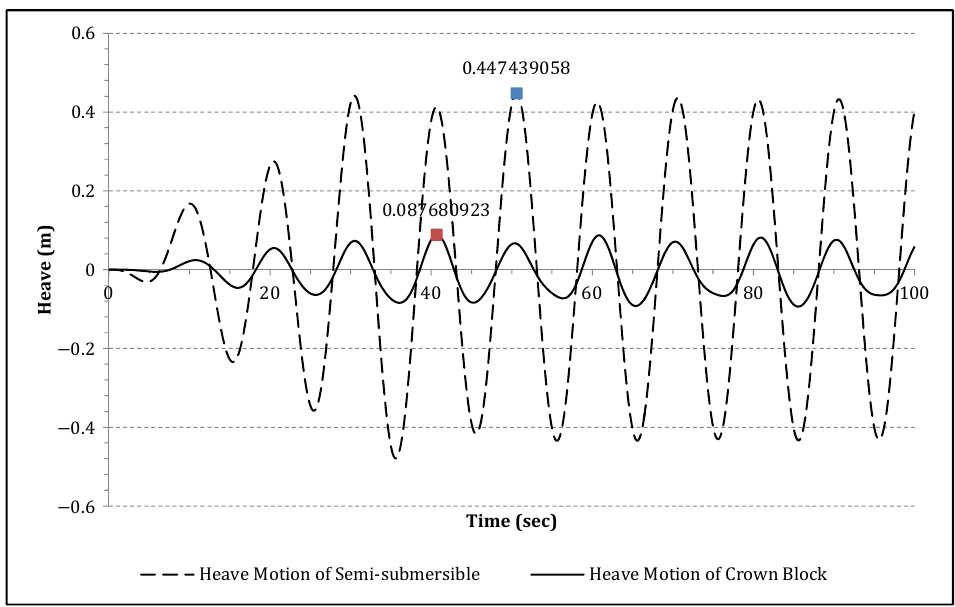
Figure 20. Heave motions of the semi-submersible and crown block for a 16.550 × 1.6-m 3 APV.